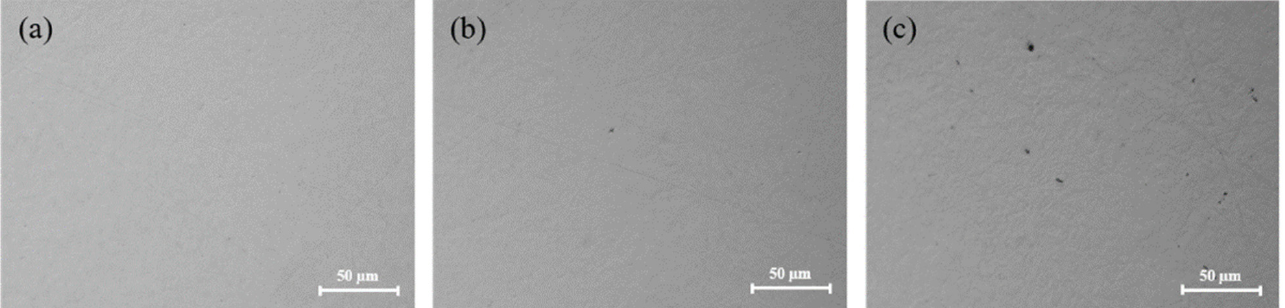
Figure 10. Surface morphologies of polished tungsten under different H 2 O 2 concentrations: ( a ) 1.0 vol.% H 2 O 2 ; ( b ) 1.5 vol.% H 2 O 2 ; ( c ) 2.0 vol.% H 2 O 2 .